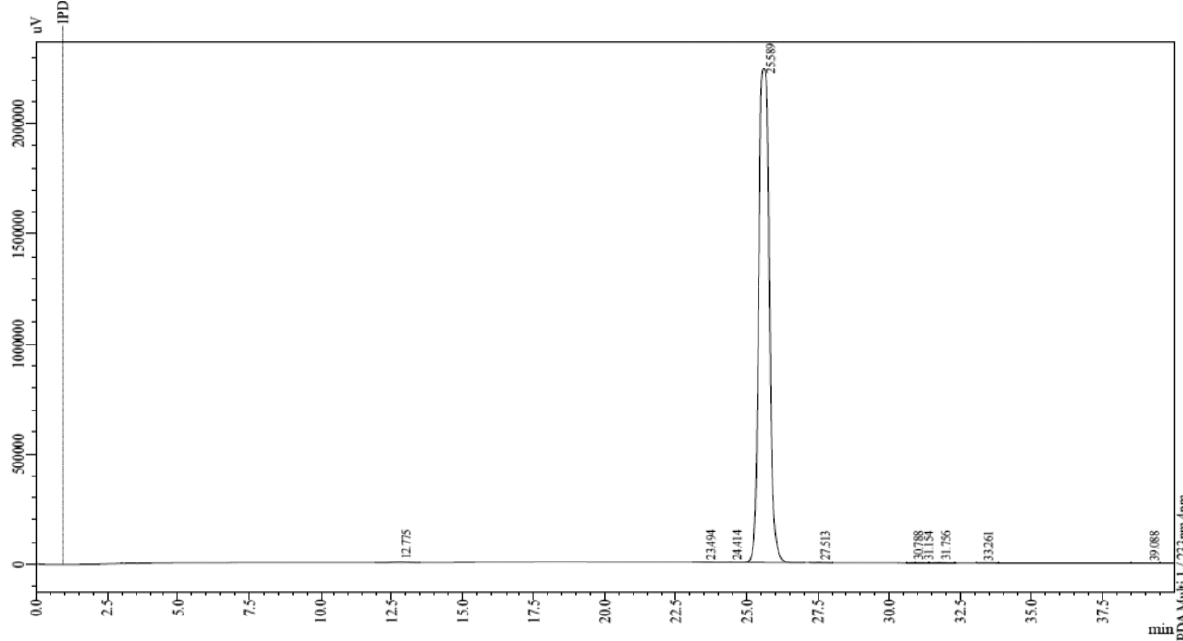
Figure 3. Chromatogram of the test